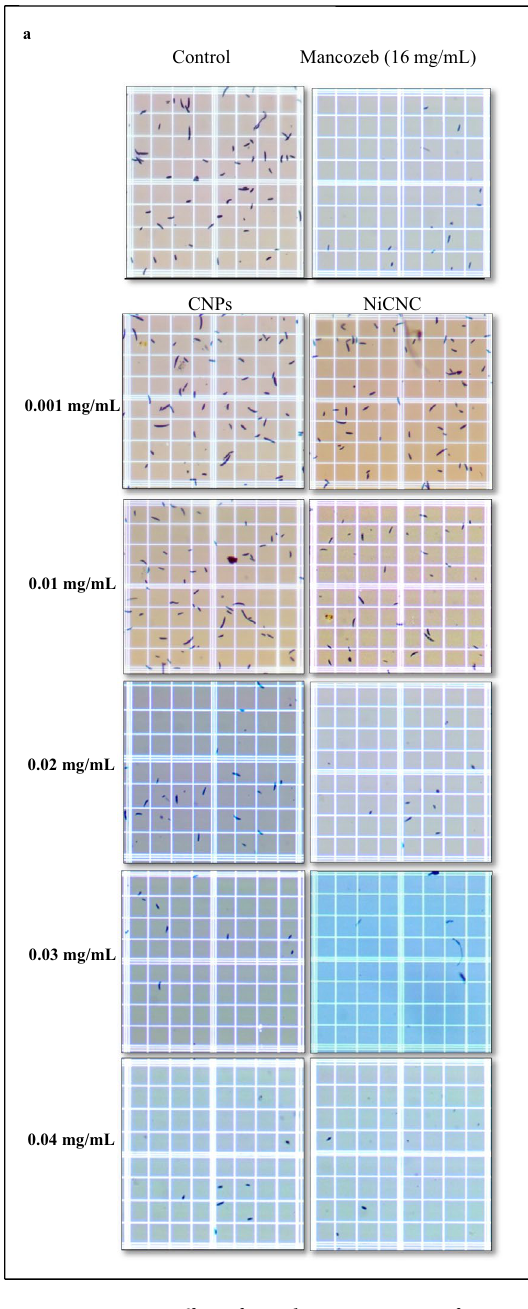
Figure 4. Effect of tested concentrations of CNPs and NiCNC on suppression of F. solani sporulation. ( a ) Sporulation count on heamocytometer observed under light microscope; ( b ) Graphical representation of the effect of CNPs and NiCNC in comparison with Mancozeb and untreated (control) spores on the formation of conidia; Values are averages of three replicates (n = 3), error bars indicate SD and different letters (a, b, c, etc.) indicate significant difference between treatments at p ≤